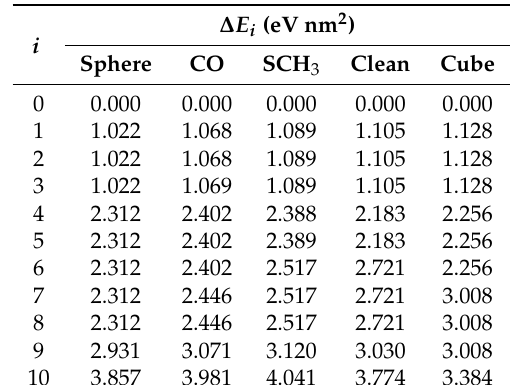
Table 2. Energy eigenvalues for five different nanoparticle shapes. The scaled energy, ∆ E = ( E − E ) V 2 3 is shown, where E 0 i i each